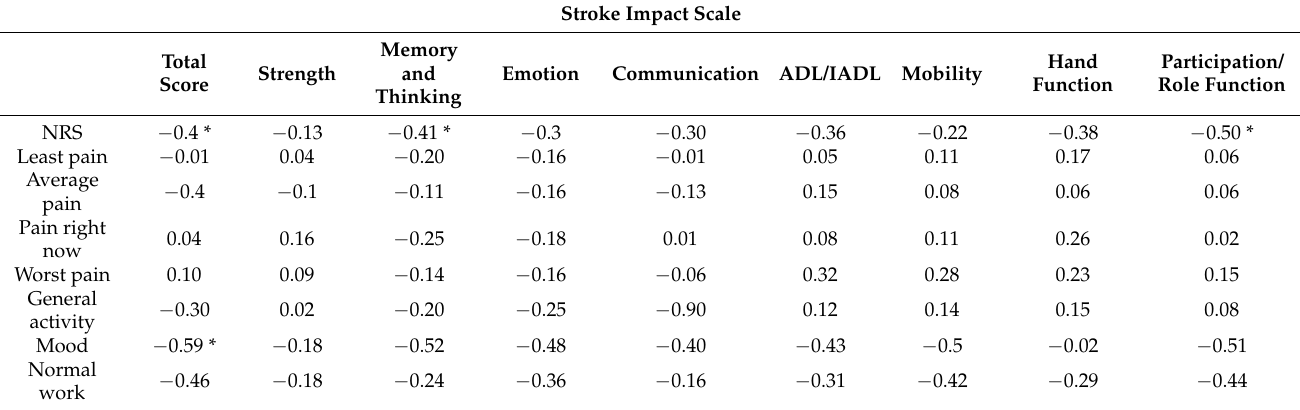
Table 4. Association between the Stroke Impact Scale scores and pain outcomes ( n = 25).